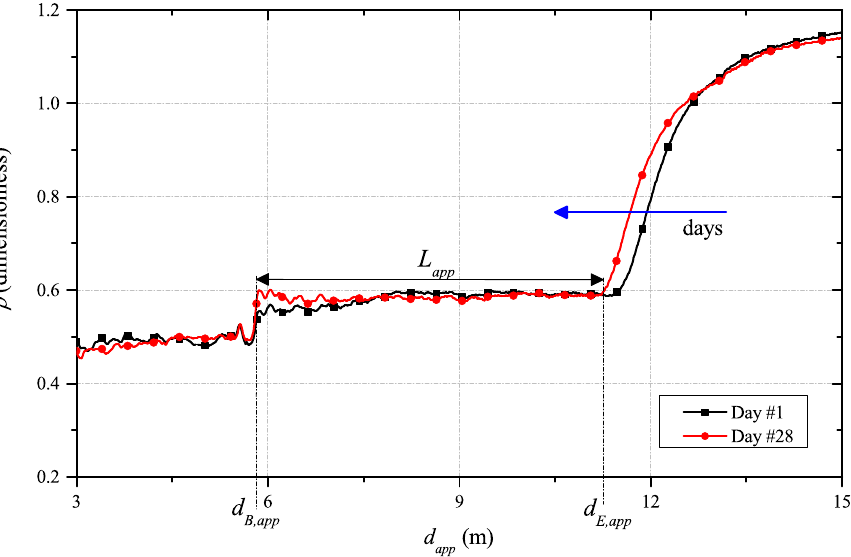
Figure 11. TDR reflectograms acquired through the d-SE, for the concrete beam on day #1 and #28. From each daily TDR reflectogram, the apparent length of the d-SE, L app , was eval- uated using (6). Employing Equation (2), the corresponding ε app can be calculated.